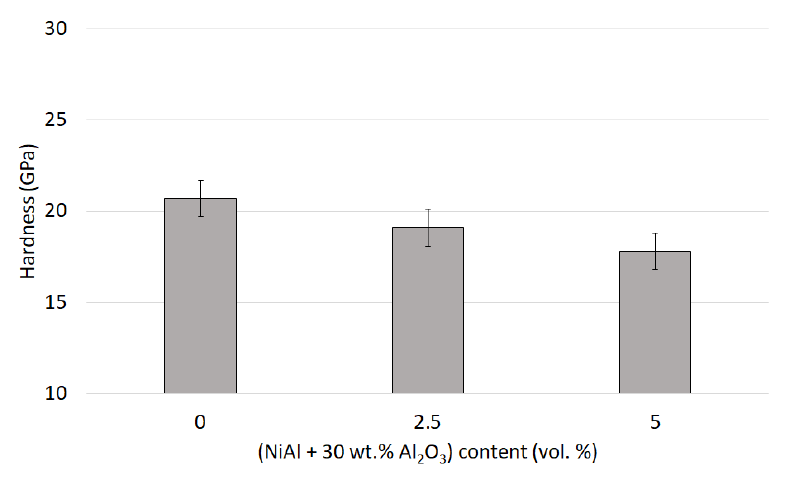
Figure 15. Hardness of the samples obtained.